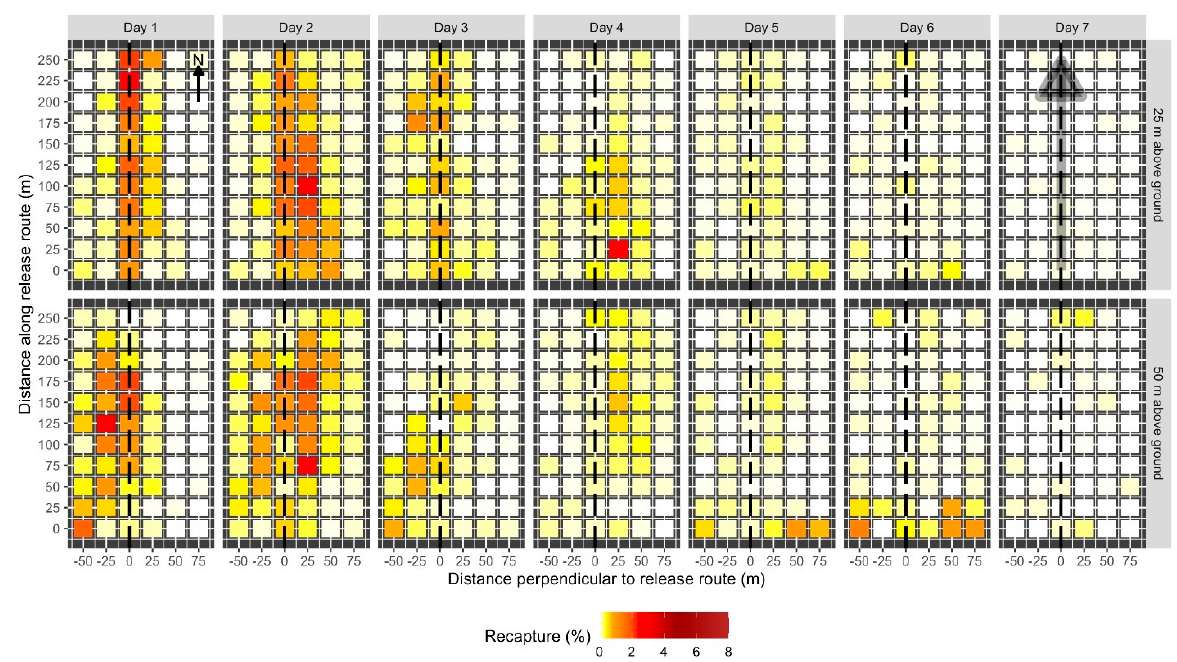
Figure 4. Spatial pattern of daily male codling moth recaptures when released from 25 m (top row) or 50 m (bottom row) above ground. Each day and altitude combination was replicated 6 times. Each colored cell represents the mean percentage of moths recaptured at a given location on a given day on a 25 m × 25 m grid of pheromone-baited traps. The intensity of shading in the cell corresponds to percentage recapture (see legend). The dashed line indicates the location of the release route over the plot. Locations of each trap along the plot and the distance perpendicular to the release route in m are indicated on the axes. Recaptures are scaled such that the sum of all cells for all seven days for a given release height equals 100%. The arrow in the upper left panel indicates plot orientation relative to north. Prevailing winds were out of the north. The shaded gray arrow in the top right panel indicates the location and direction of the release route.